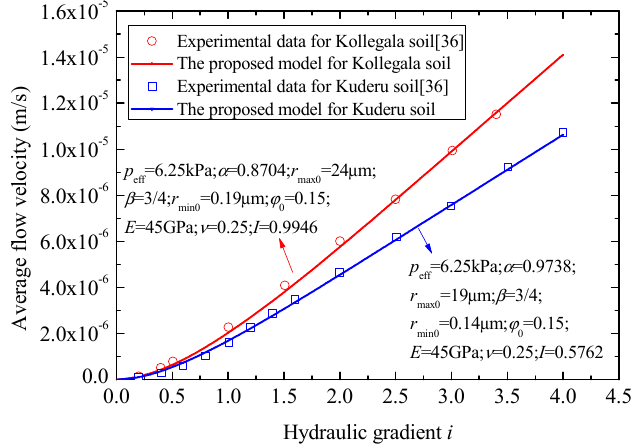
Figure 1. A comparison between the experimental data [36], and results of the proposed model.